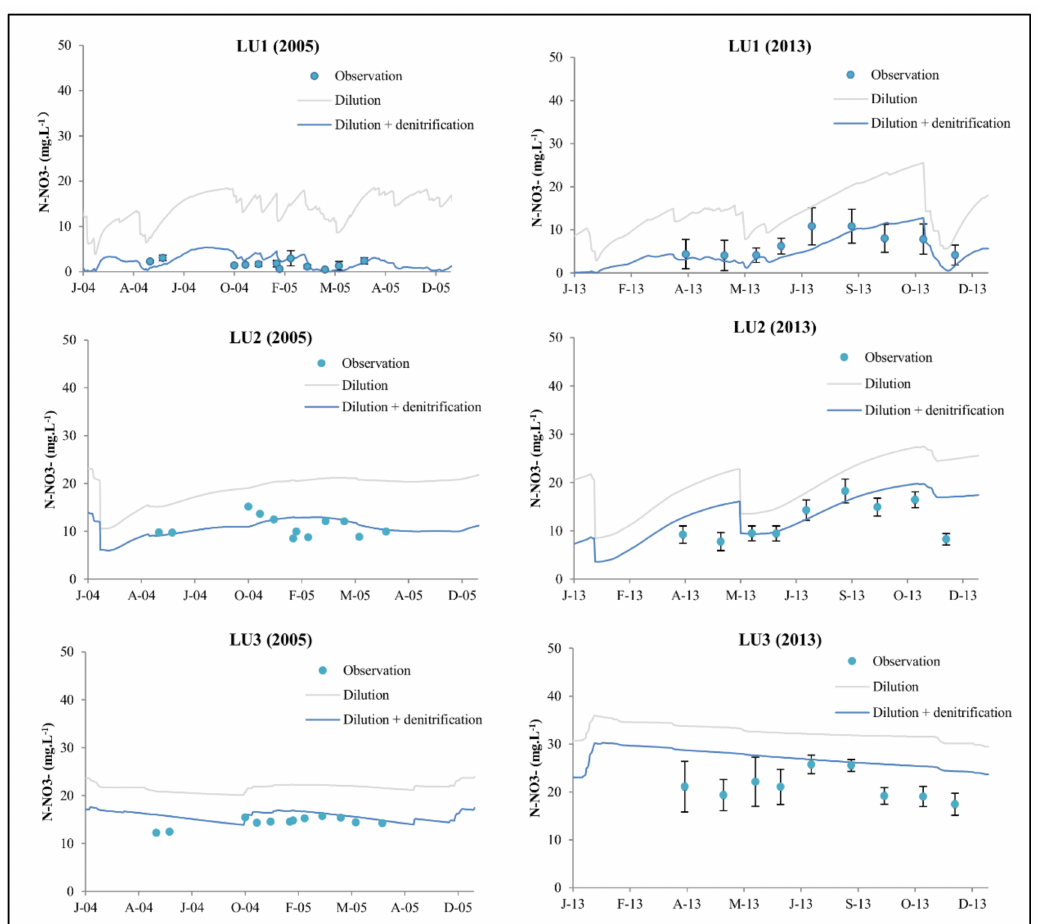
Figure 5. Simulated and observed nitrate concentrations in the aquifer of the LUs during the periods of 2004–2005 and 2013, where ‘Dilution’ is the simulated results with the infiltrated river water and ‘Dilution + denitrification’ is the simulated results with the infiltrated river water and denitrification. The evaluation of the performance of the simulated nitrate concentrations is shown in Figure